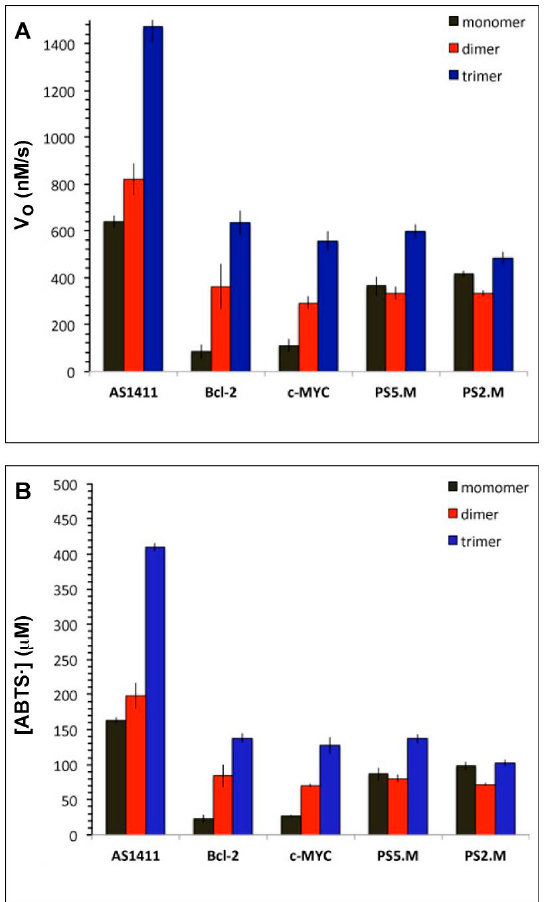
Figure 3. DNAzyme activities of DNAzymes. ( A ) Initial Rates (expressed as V o , nM / s) were calculated from the slope of the initial linear portion (typically, the first 30 s) of the reaction curves shown in Figure 2. ( B ) The amount of ABTS • radical produced after 300 s from the activity of 1 µ M DNAzyme were determined from the endpoint of the reaction time course shown in Figure 2. See Materials and Methods .